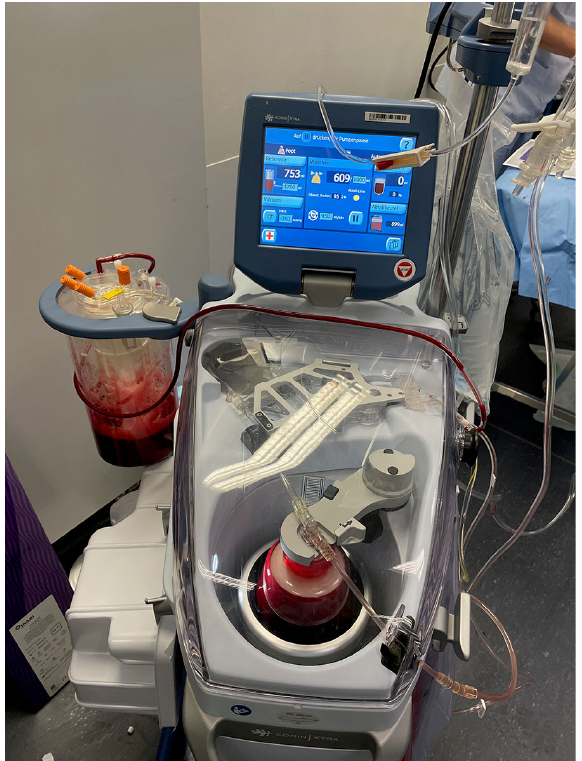
Figure 7. Cell Saver ® in operation processing the retrieved blood for autotransfusion.